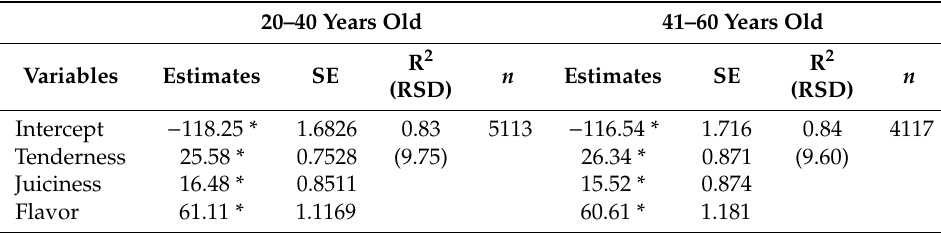
Table 9. Pairwise comparisons of age groups for consumer satisfaction.